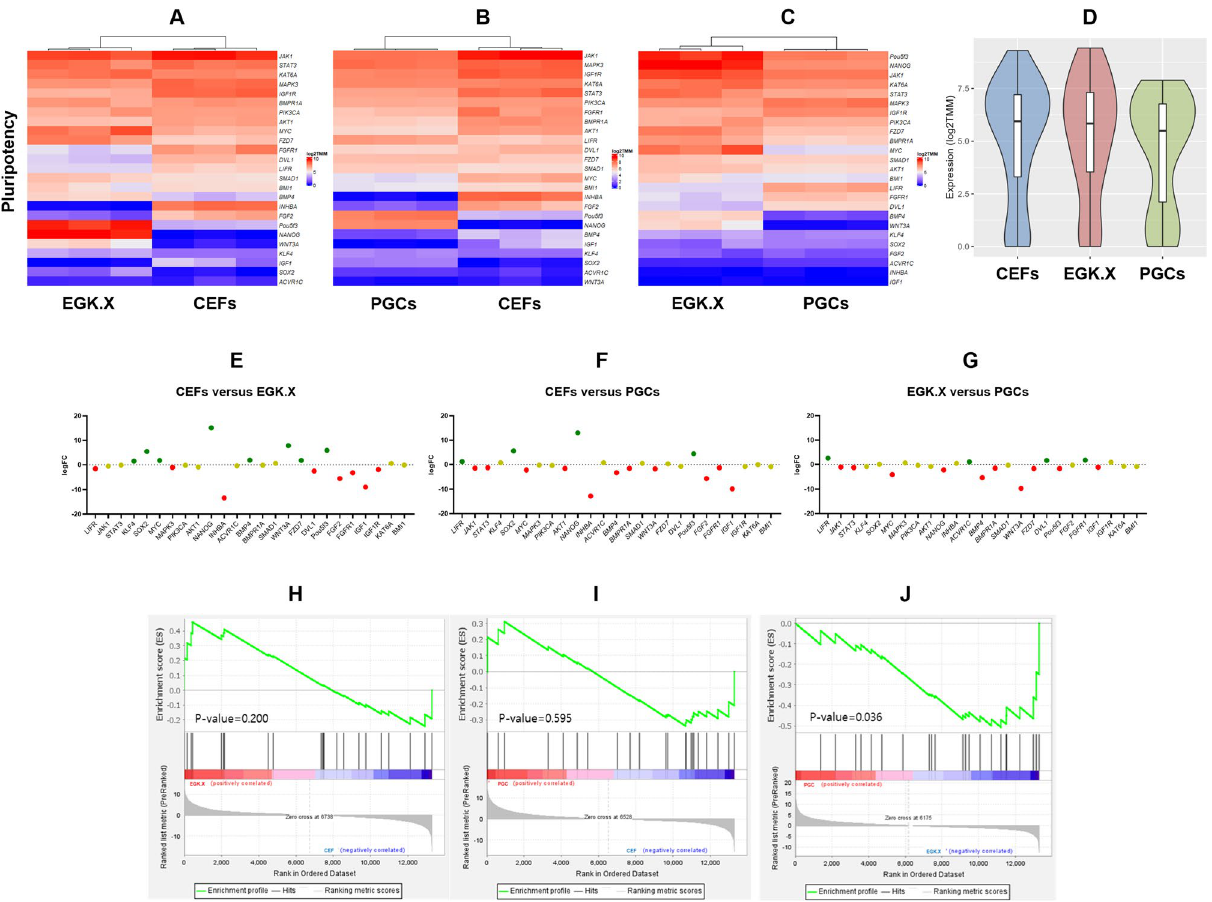
Figure 5. Expression profiling of pluripotency regulating genes. ( A–C ) Heatmaps using log 2 TMM values of the normalized read counts of pluripotency regulating genes in CEFs and EGK.X blastoderms ( A ), CEFs and PGCs ( B ), and EGK.X blastoderms and PGCs ( C ) were prepared separately for better visualization. ( D ) Violin plots were prepared with the log 2 TMM values to visualize the overall expression of pluripotency regulating genes in CEFs, EGK.X blastoderms, and PGCs. ( E–G ) DEGs of pluripotency regulating pathway between the test samples. DEGs in EGK.X blastoderms compared with CEFs, DEGs in PGCs compared with CEFs, and DEGs in PGCs compared with EGK.X blastoderms were shown in ( E – G ), respectively. Green: significantly upregulated. Red: significantly downregulated. Yellow: unregulated. ( H–J ) GSEA of pluripotency regulating genes at CEFs versus EGK.X blastoderms ( H ), CEFs versus PGCs ( I ), and EGK.X blastoderms versus PGCs ( J )